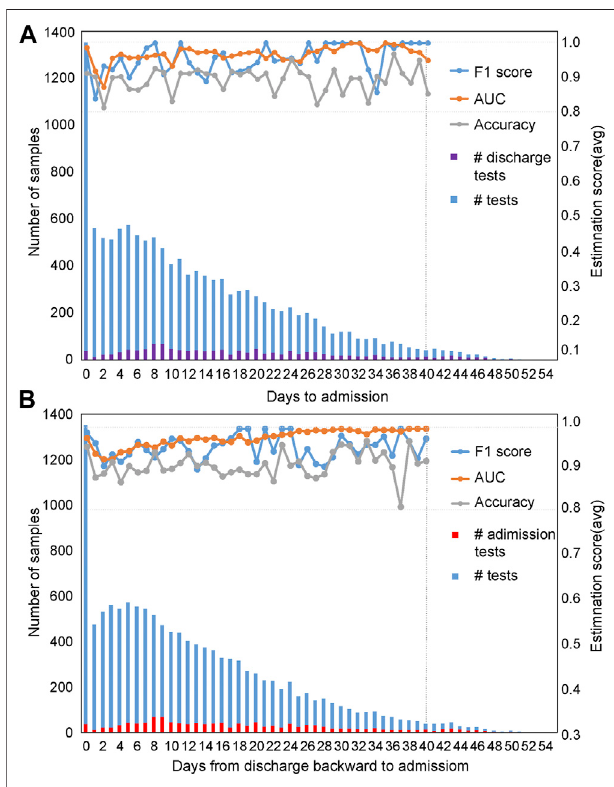
FIGURE4| Evaluationofpredictionresultsbasedontimeserieswith fi ve selected features. The prediction results were evaluated based on time series usingtheadmission-day0 (A) andthedischarge-day0 (B) asstartpoints.The fi rst y -axis represents the number of samples enrolled, while the second y -axis represents the estimation scores. The purple bar represents the number of patients discharged from the hospital on that day, while the red bar indicates the number of patients admitted to the hospital on that